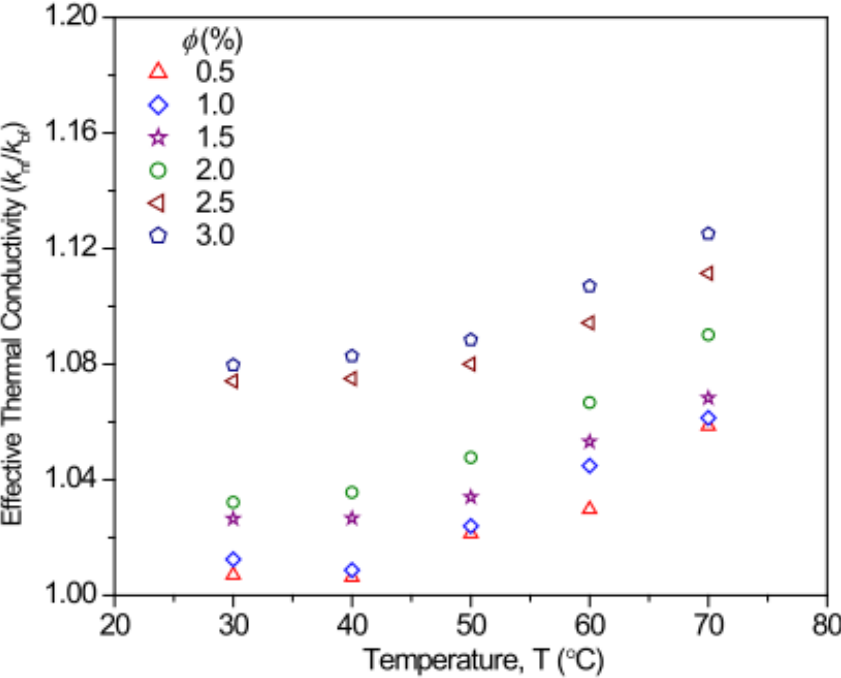
Figure 11. Effect of increasing temperature on effective thermal conductivity of TiO 2 –SiO 2 (20:80)/bi- ogycol-DW (40:60) nanofluids under different volume concentration [52]. (20:80)/biogycol-DW (40:60) nanofluids under different volume concentration